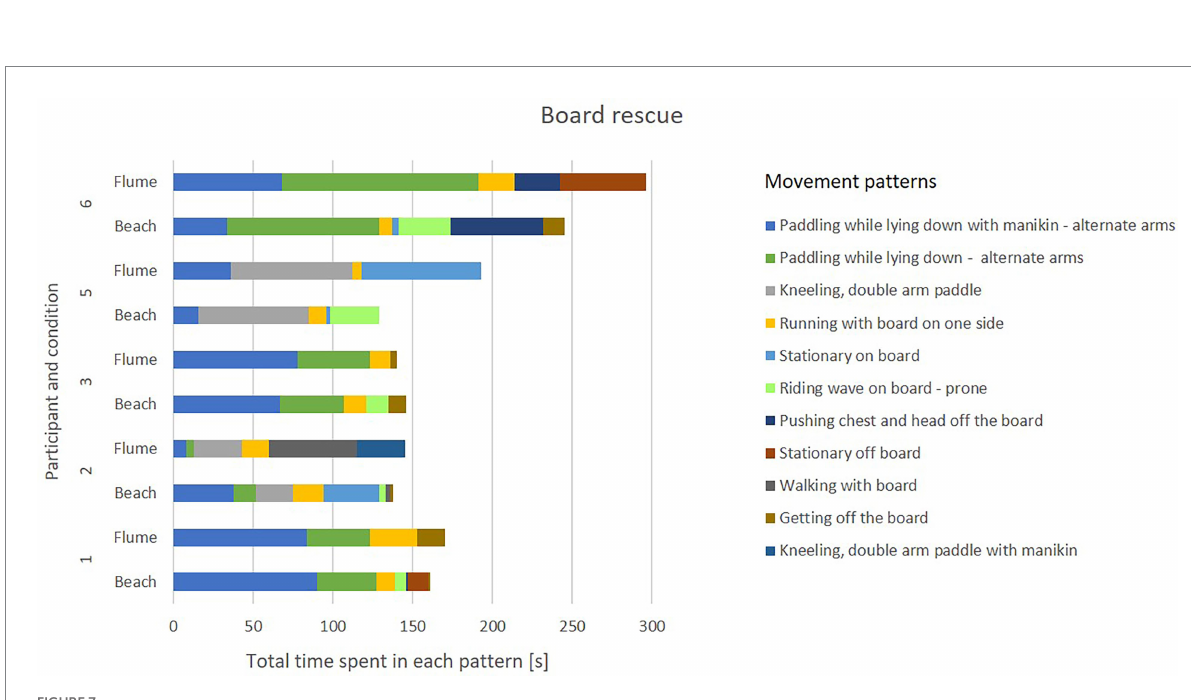
FIGURE 7 Movement patterns employed during board rescue in ocean vs. flume conditions. Note: The colors do not indicate the same patterns as in Figure